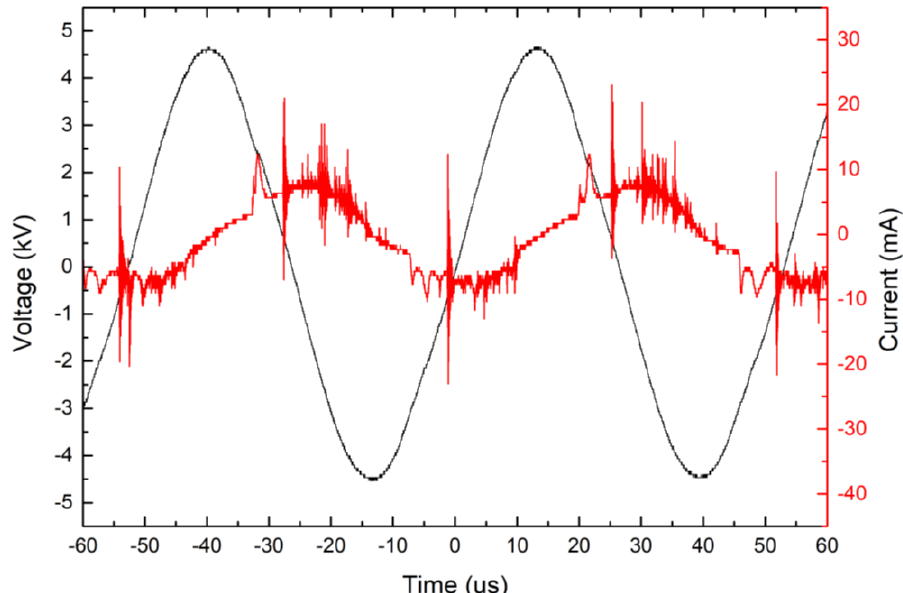
Figure 2. Typical current and voltage waveforms for the APPJ.